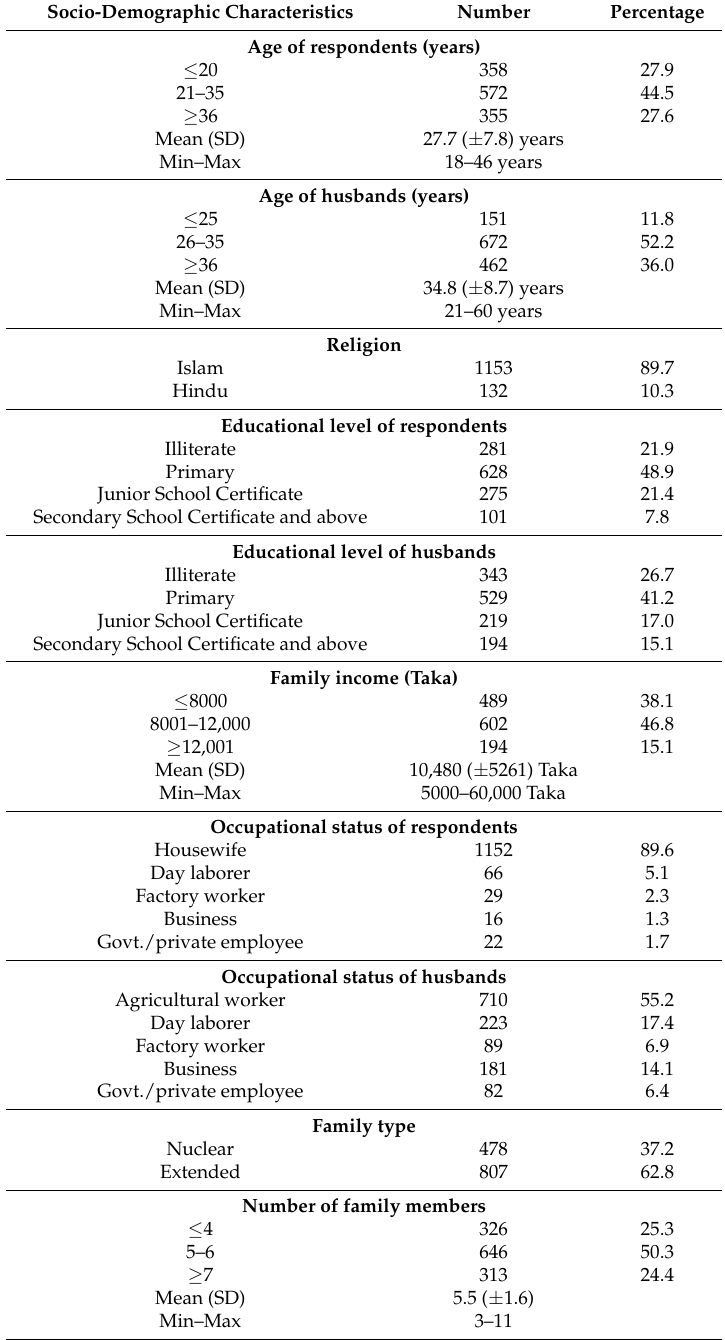
Table 2. Socio-demographic characteristics of respondents ( n =